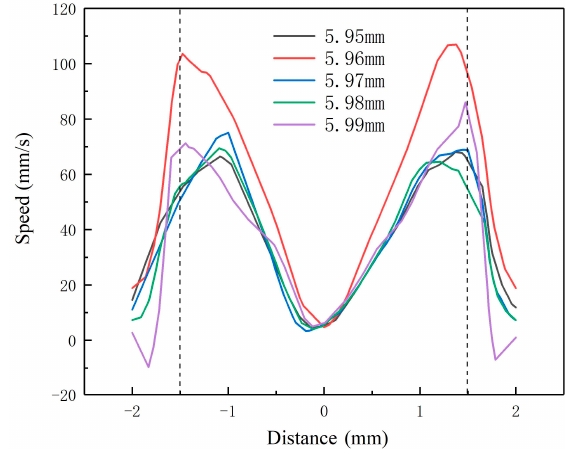
Figure 15. Distribution curve of flow velocity of plastic metal at the bottom of weld seams with different lengths of pin (1000 rpm, 120 mm/min).